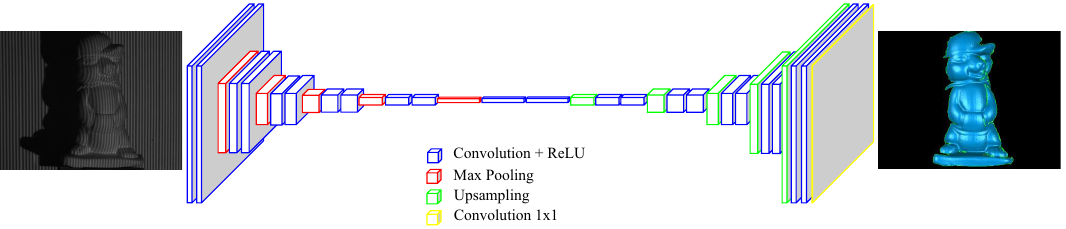
Figure 2. Illustration of the single-shot 3D shape reconstruction system using FPP and CNNs. Three different deep CNNs are adopted in this work for comparison to find the best